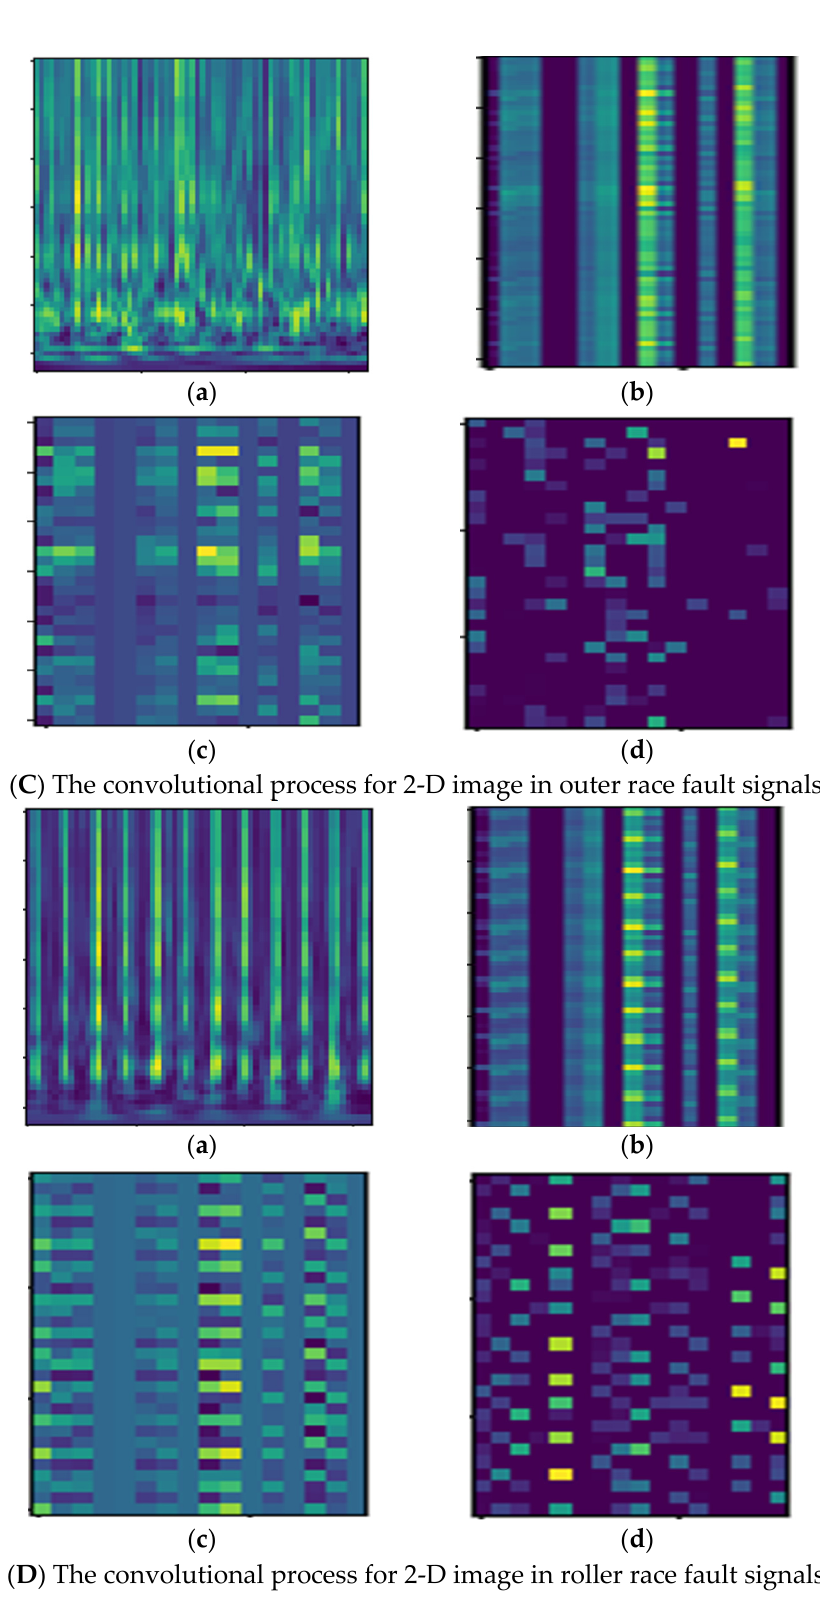
Figure 9. The visualization for convolutional process in 2–D images under different condition. ( a ) 2–D images for normal, inner race fault, roller race fault, outer race fault vibration, ( b – d ) visualization for convolutional process in ( A – D ).